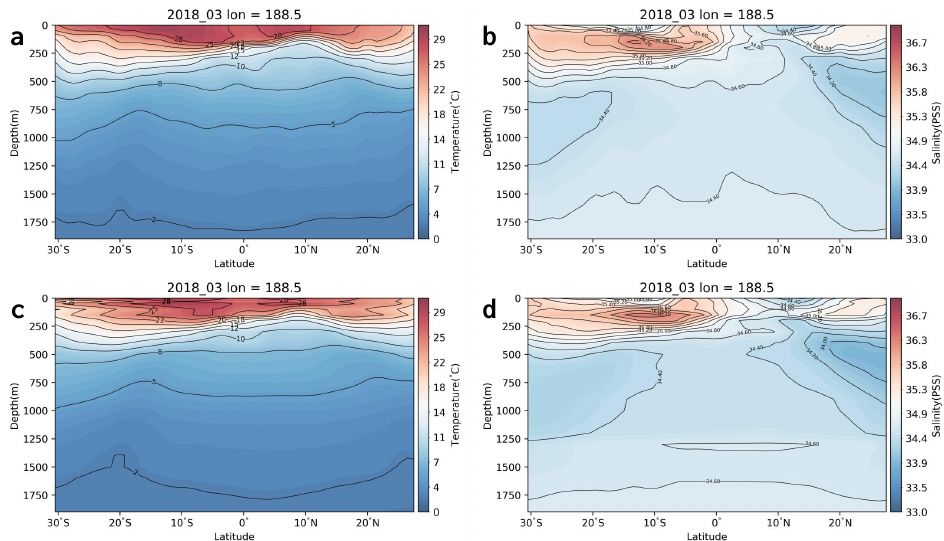
Figure 8. The meridianal vertical profiles of the ocean subsurface thermohaline in March 2018 at the longitude of 188.5° for ( a ) Argo ST, ( b ) Argo SS, ( c ) ConvLSTM-inversed ST, and ( d ) ConvLSTM- inversed